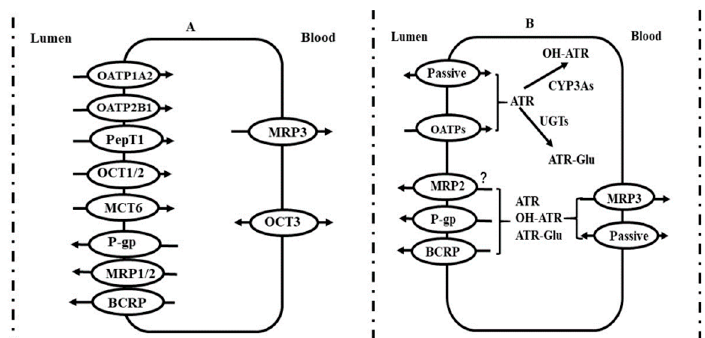
Figure 2. ( A ) Possible location of main transporters in human intestine and ( B ) roles of transporter- CYP3A interplay in disposition of atorvastatin in enterocytes . Symbol : ATR, atorvastatin; BCRP, breast cancer resistance protein; MCTs, monocarboxylate transporters; MRPs, multidrug resistance- associated proteins; OATPs, organic anion transporting polypeptides; OCTs, organic cation transporters; PepT1, peptide transporters; P-gp, P-glycoprotein; OH-ATR, hydroxyl atorvastatin; ATR-Glu, atorvastatin acyl